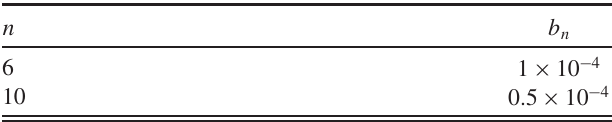
TABLE I. Maximum systematic values of the field multipoles (defined in Appendix) expressed at 7 mm.